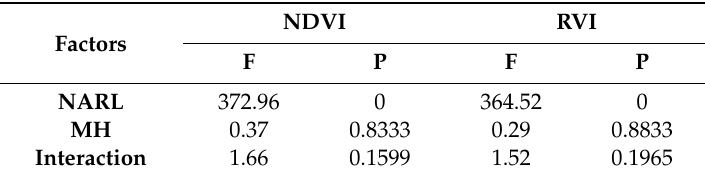
Table 3. Two-way ANOVA results for NDVI and